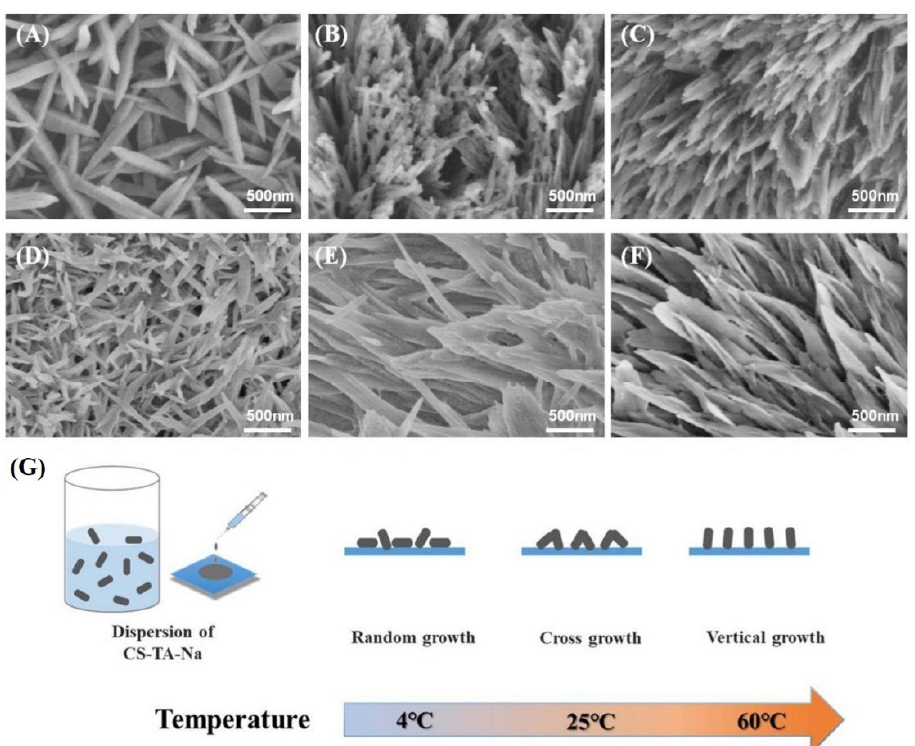
Figure 6. Scanning electron microscope (SEM) images: 5 μ L 0.05 wt% CS-TA-Na dispersion drop-cast on glass substrate at ( A ) 4 °C, ( B ) 25 °C and ( C ) 60 °C, on PTFE substrate at ( D ) 4 °C, ( E ) 25 °C and ( F ) 60 °C. ( G ) Schematic of self-assembly of CS-TA-Na at different temperatures.